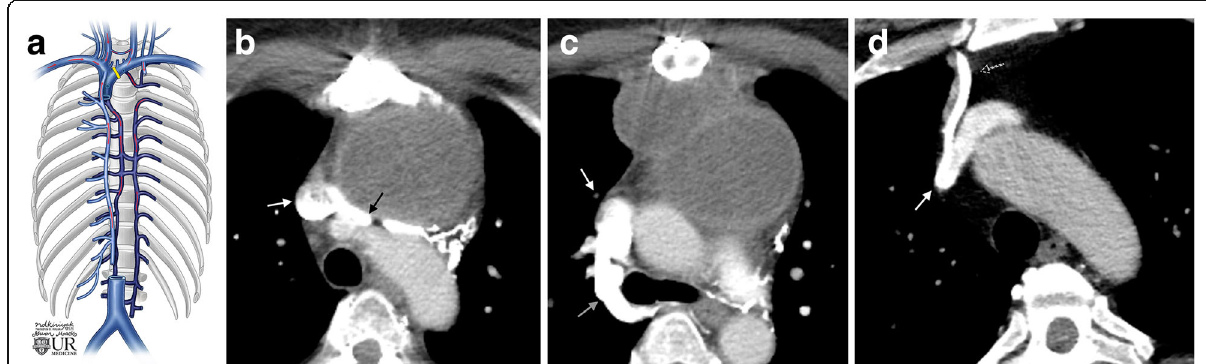
Fig. 8 Brachiocephalic blockage. a Schematic image of a brachiocephalic obstruction and pathway for collateral flow. b Axial CT image of a 59-year-old female with a mediastinal tumor demonstrating extrinsic compression of the left brachiocephalic vein (black arrow) before it enters the SVC (white arrow). c Axial CT image in the same patient showing a dilated azygos vein (gray arrow) draining into the SVC (white arrow). d Axial CT image in a different patient demonstrates a prominent right internal thoracic vein (dashed arrow) draining into the SVC (white arrow) bypassing a right-sided brachiocephalic blockage (not pictured)